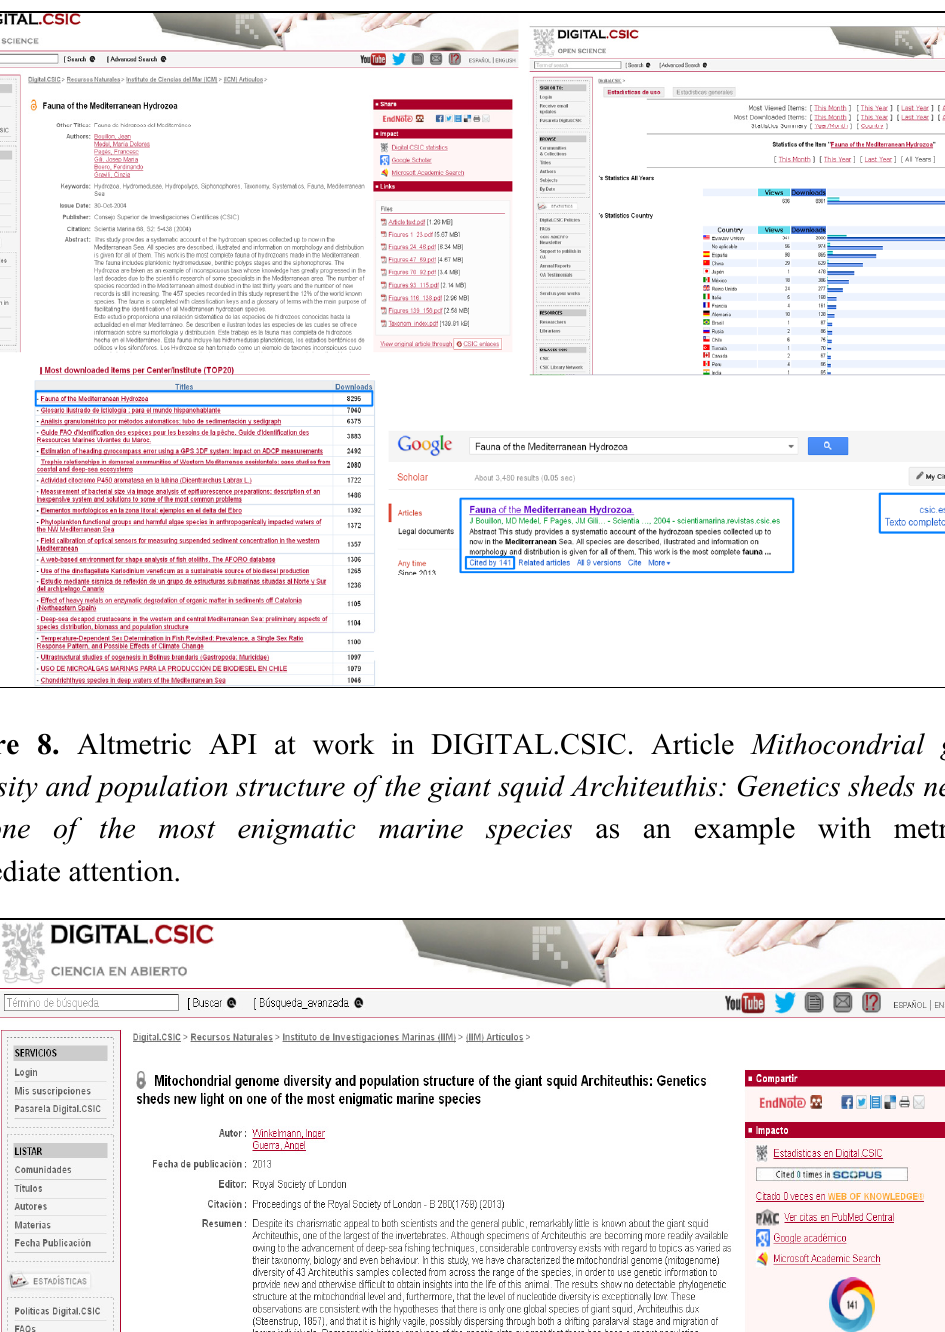
Figure 7. DIGITAL.CSIC as a gateway to retrieve multi-level impact data. Fauna of the Mediterranean Hydrozoa .